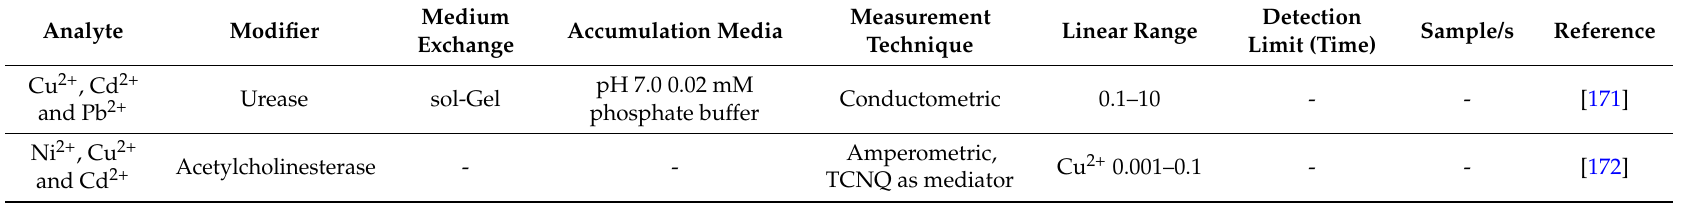
Table 10. Reports of screen-printed biosensors for the determination of metal